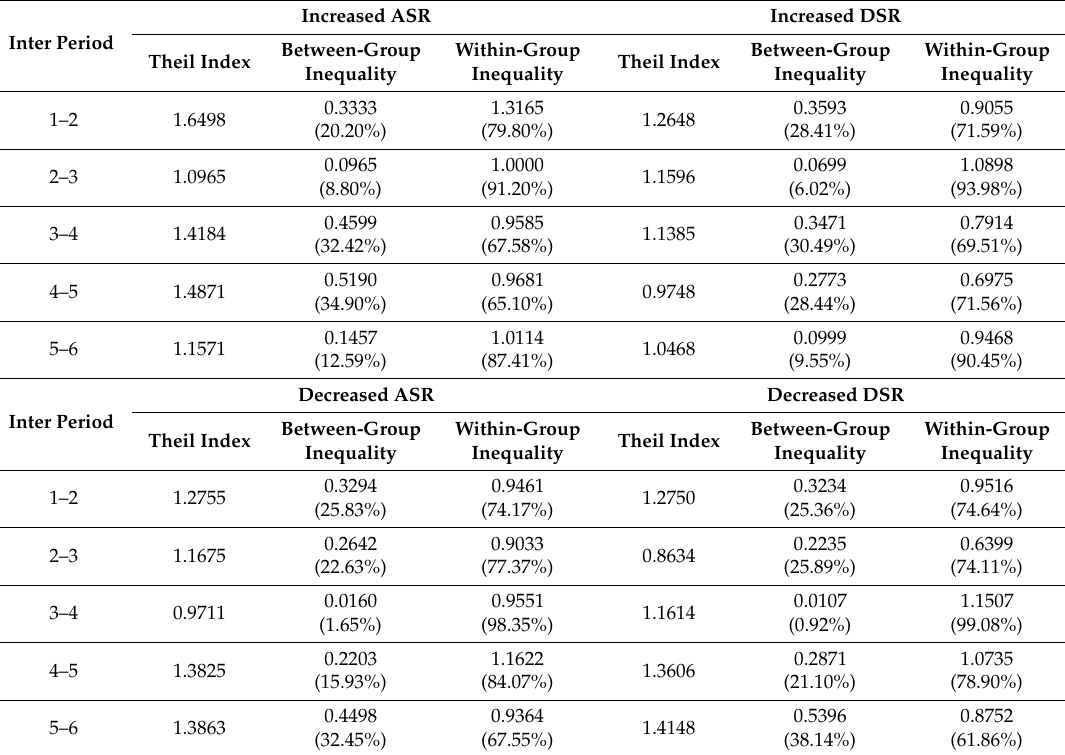
Table 8. The Theil index and its decomposition of the service rate change on